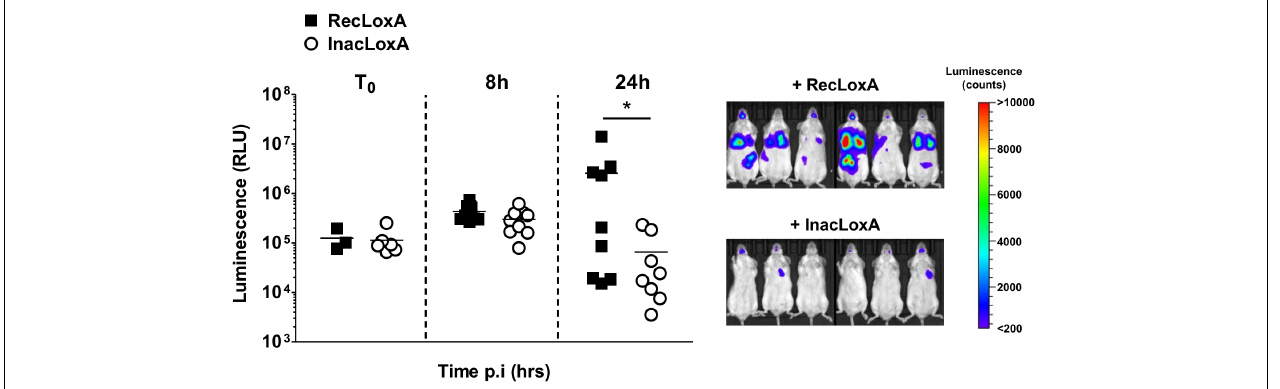
FIGURE 5 | Recombinant LoxA activity promotes P. aeruginosa persistence in lungs. Balb/c mice were intranasally instilled with both PAK’ (cid:49) loxA-luxCDABE (1.10 8 cfu/mice) and 5 µ g/mice of active LoxA (RecLoxA) or heat-inactivated recombinant LoxA (InacLoxA). Lung infection was assessed by quantifying P. aeruginosa -associated luminescence emission in live animals. Data represent the mean ± SEM ( n = 6–9 mice/group) and are representative of three independent experiments, ∗ p < 0.05.